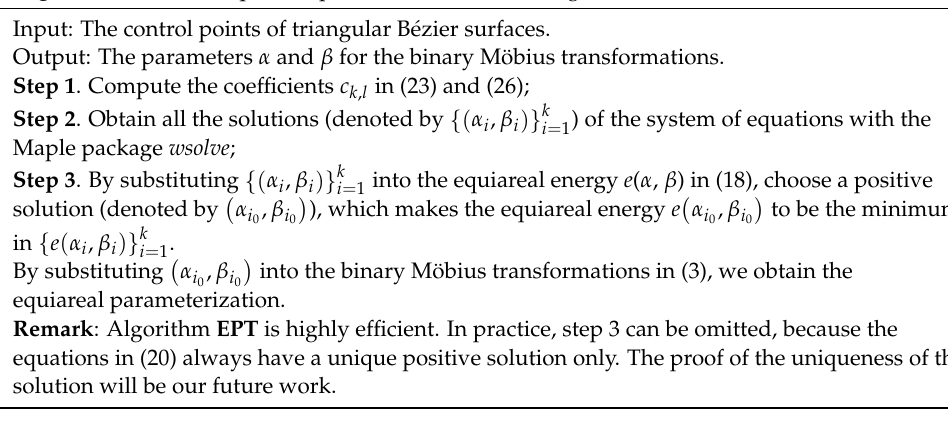
Algorithm EPT : The equiareal parameterization of triangular B é zier surfaces.